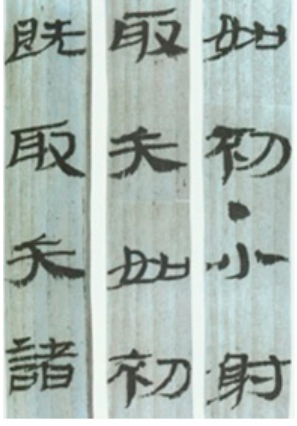
Figure 1. Wuwei bamboo slips.